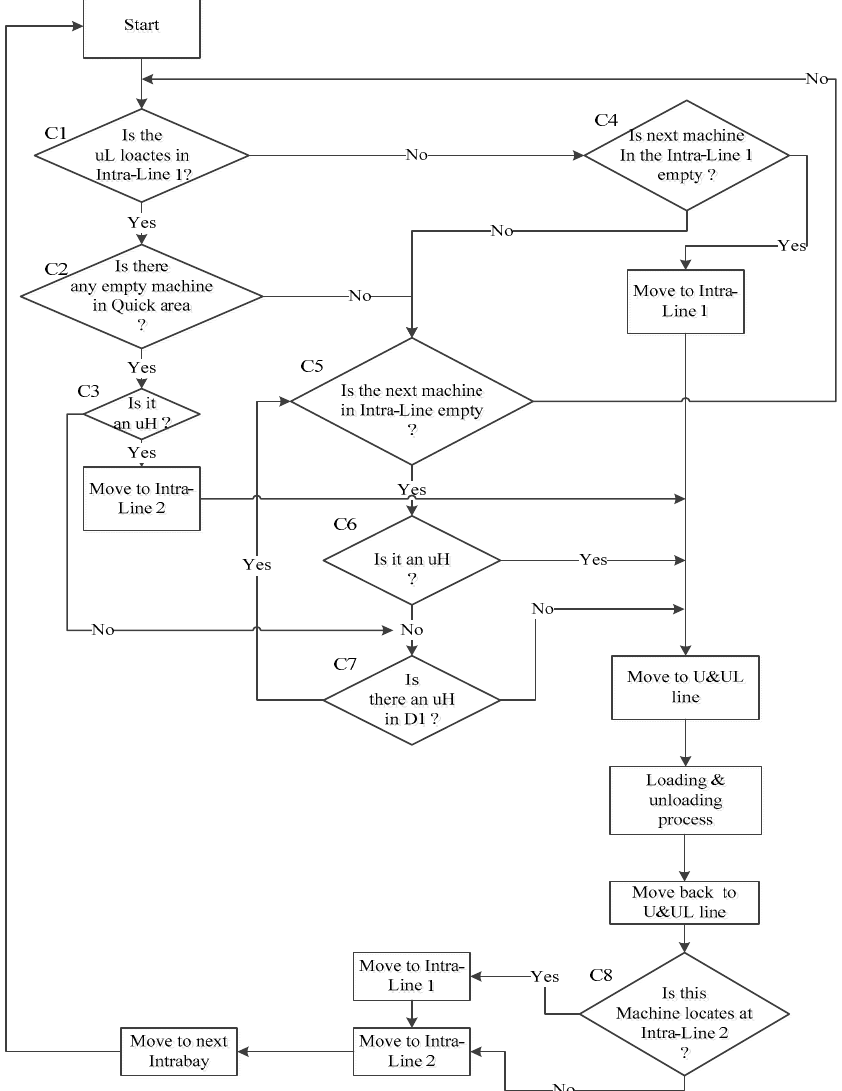
Figure 12. The flow chart of the a-HPDB (Heuristic Preemptive Dispatching Method using Activated Roller Belting) method.